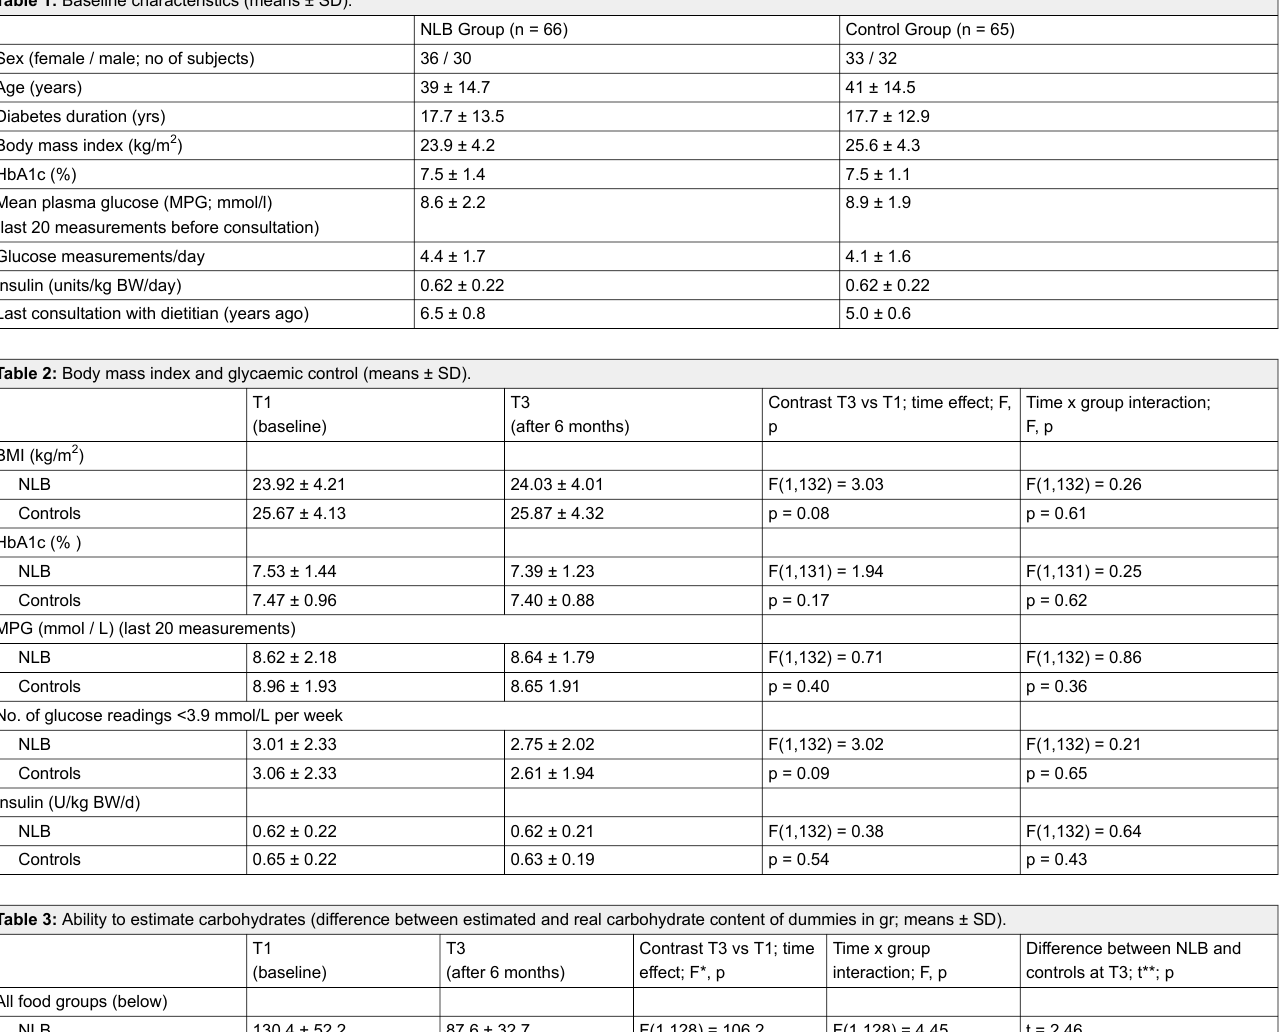
Table 1: Baseline characteristics (means ± SD).